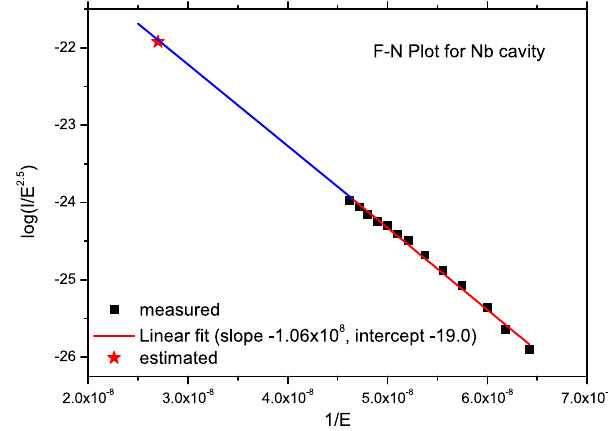
FIG. 11. F-N plot of the dark current from the niobium cavity. In the horizontal axis E ð V = m Þ is the E -field amplitude. The star is the data extended from the linear fit with respect to E ¼ 30 MV = m, I ¼ 1 × 10 − 3 z: max